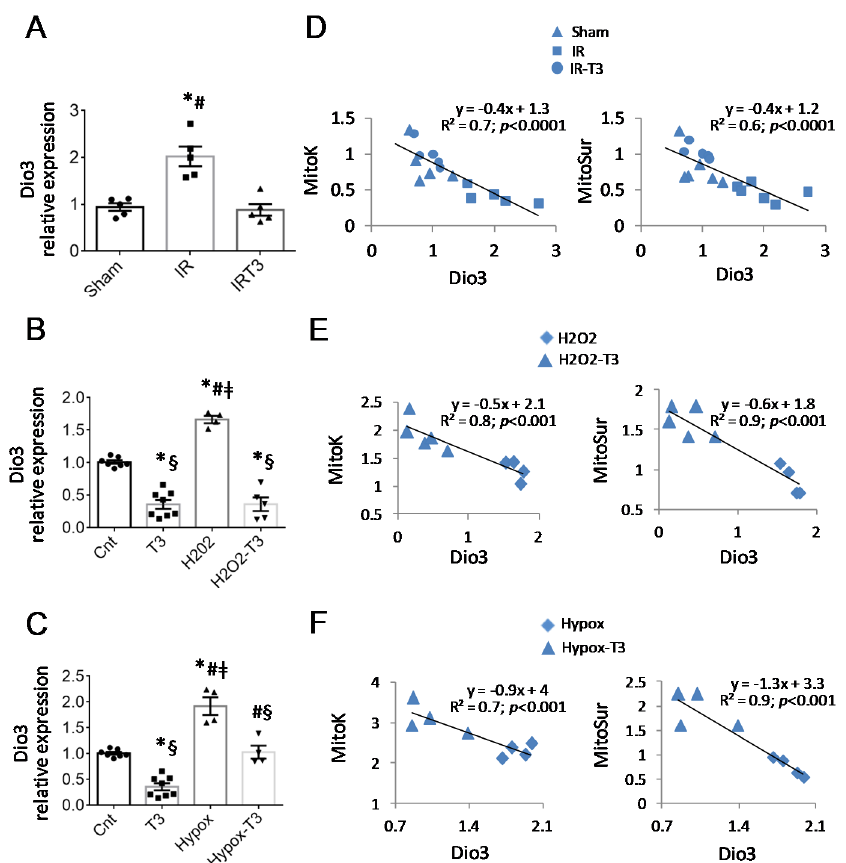
Figure 4. Treatment with T3 reduces the expression of Dio3 in in vivo and in vitro pathological conditions. ( A ) Quantification of the relative expression of Dio3 in the LV area at risk 3 days after IR induction ( n = 5 animals per group; * p < 0.0001 vs. sham; # p < 0.0001 vs. IRT3. ( B , C ) Quantification of the relative expression of Dio3 in NRCM subjected to hypoxic or oxidative stress and then treated with T3 or its vehicle for 48 h. n ≥ 4; * p < 0.0001 vs. cnt; # p < 0.0001 vs. T3; § p < 0.0001 vs. Ipox or H 2 O 2 ; ‡ p < 0.0001 vs. Ipox-T3 or H2O2-T3. ( D ) Linear regression analysis between expression levels of Dio3 (independent variable) and mitoK or mitoSur (dependent variables) in the LV area at risk at 3d post IR. ( E , F ) Linear regression analysis between expression levels of Dio3 (independent variable) and mitoK or mitoSur (dependent variables) in NRCM subjected to H 2 O 2 or hypoxic